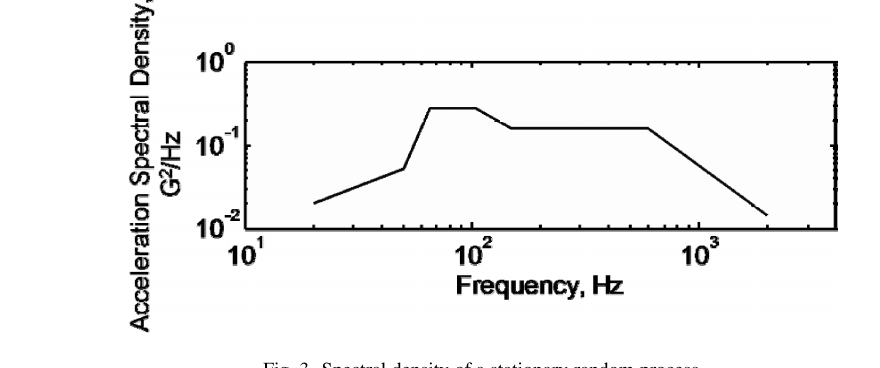
Fig. 3. Spectral density of a stationary random